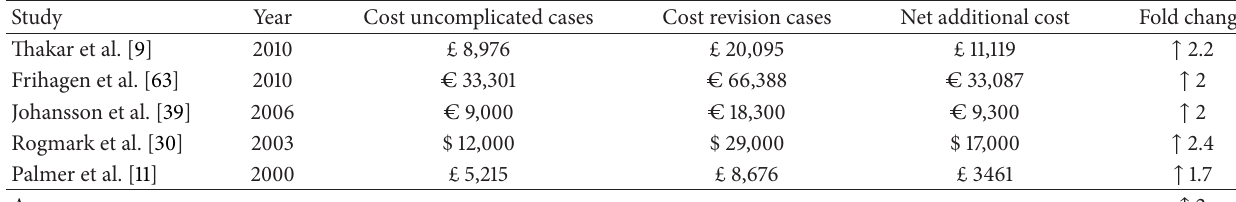
Table 5: Additional cost of fixation